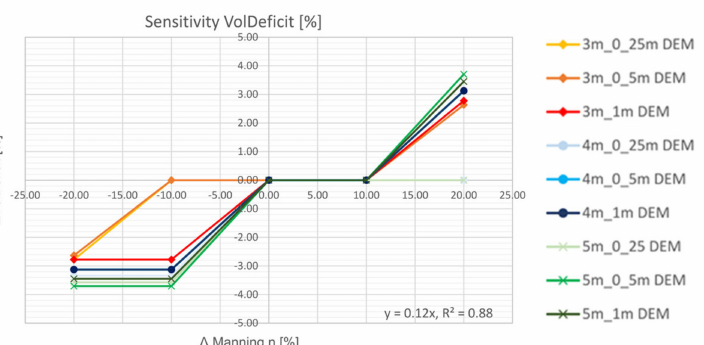
Figure 29. Comparison of the model sensitivity (S-VD) for Manning’s n values and the evaluated mesh and DEM resolutions with the averaged elasticity ratio